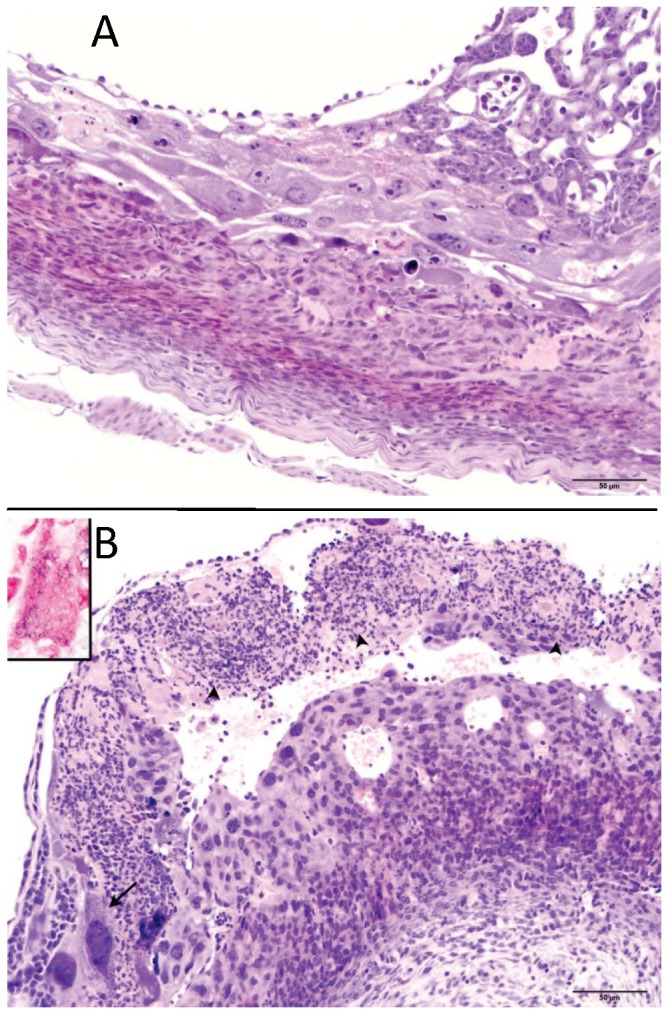
Histological examination of conceptuses from mice with intrauterine and extrauterine infections.Hematoxylin/eosin stained sections of the conceptuses from two of five mice identified in Table 2 are shown. (A) Uterus and placenta (200x magnification) of mouse 2 with no detected uterine cfu: no lesions were noted. (B) Uterus and placenta (200x magnification) from mouse 7, showing > 106 uterine listerial cfu. The arrow heads denote inflammation and necrosis indicated by the degenerative neutrophils mixed with cellular debris and fibrin that have focally effaced the chorionic plate. The arrow identifies an infected giant trophoblast that has intracellular gram positive rods (see Gram-stained inset: 1000x).